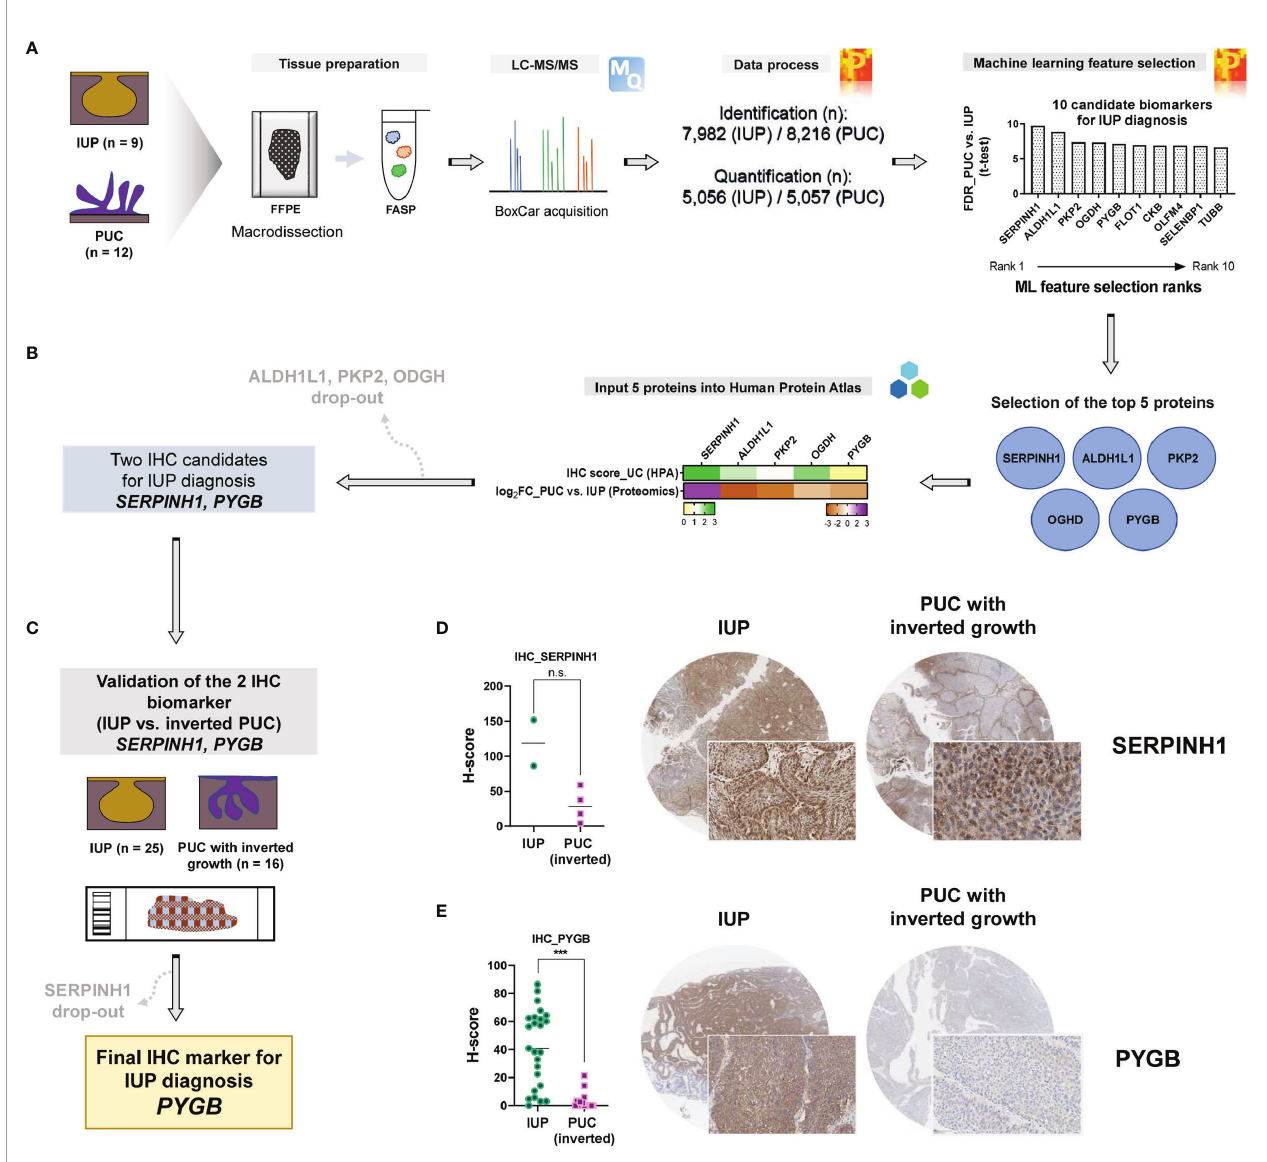
FIGURE 4 | Identi fi cation of PYGB as an accurate biomarker to differentiate inverted urothelial papilloma (IUP) from papillary urothelial carcinoma (PUC) with inverted growth. (A) Summary of the machine learning feature selection of 10 candidate biomarkers. (B) Selection of the fi ve top-ranked proteins and further narrowing-down to the two proteins (SERPINH1 and PYGB), based on The Human Protein Atlas. (C) Immunohistochemical validation of SERPINH1 and PYGB in an independent cohort of IUP and PUC with inverted growth. (D) SERPINH1 immunostaining in IUP vs. PUC with inverted growth (Mann – Whitney p = 0.1333; n.s., not signi fi cant). (E) PYGB immunostaining in IUP vs. PUC with inverted growth (***Mann – Whitney p <